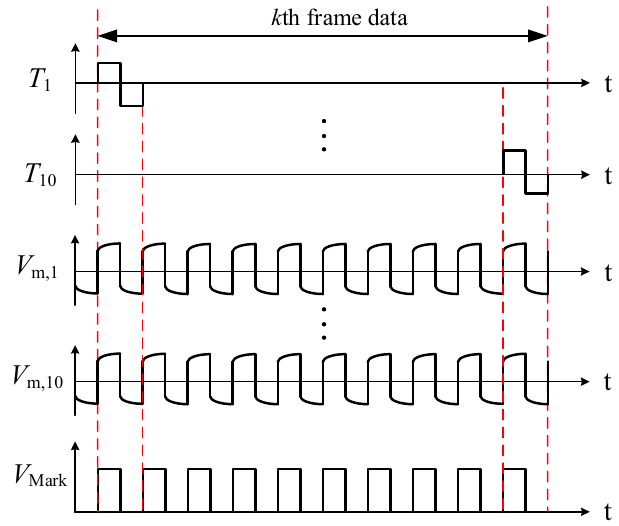
Figure 2. Schematic of the sensor excitation scheme and response signals.